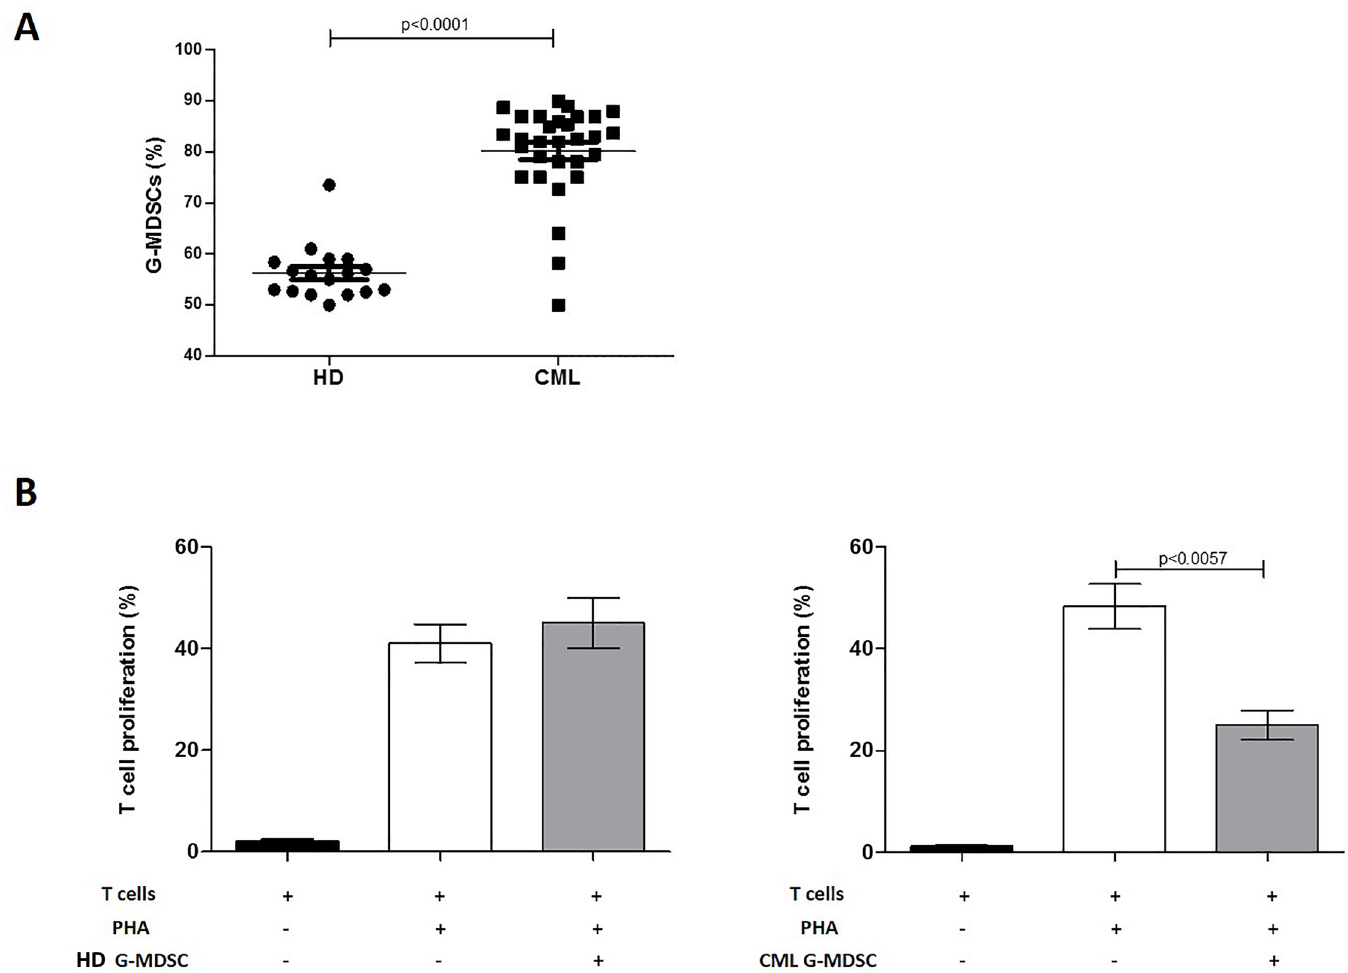
Fig 1. Increased frequency of G-MDSC in CML patients. A. Circulating G-MDSC were quantified and expressed as percentage of CD11b+CD33+CD15+ CD14-HLA-DR- cells in EDTA whole blood samples using sequential gating strategy in flow cytometry. B. Only CML G-MDSC were able to inhibit T cell proliferation in autologous co-cultures. Mean frequency of CD3+ CFSE dim cells ± SD from four independent experiments is shown.